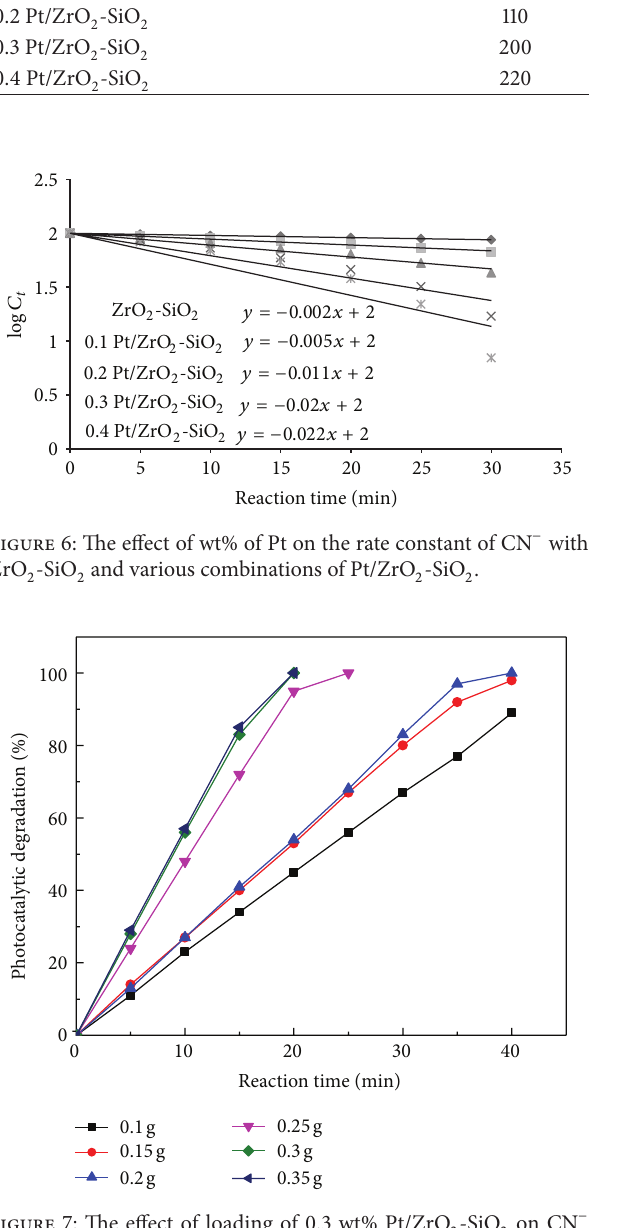
Figure 7: The effect of loading of 0.3 wt% Pt/ZrO 2 -SiO 2 on CN − degradation.